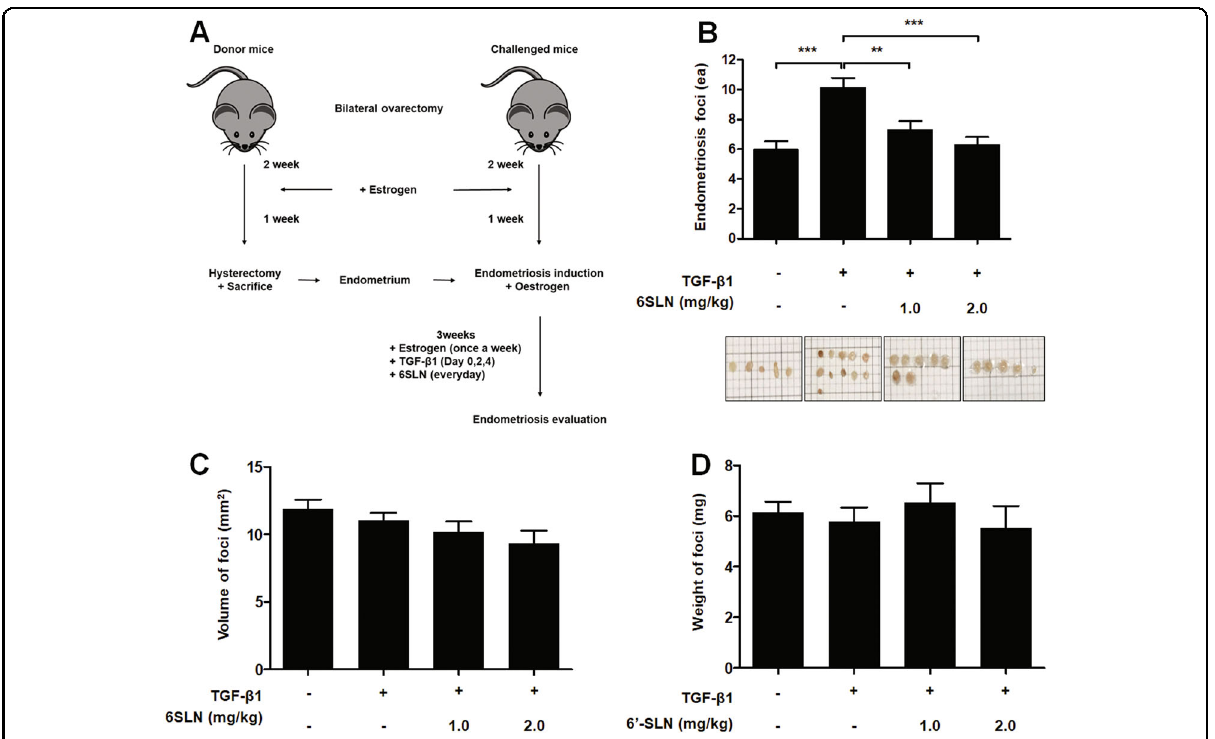
Fig. 6 6 ʹ -SLN treatment attenuates TGF- β 1-induced endometriosis in C57BL/6 mice a Schematic diagram of the mouse endometriosis model. Endometriosis was induced at day 0. Donor and challenged mice were subjected to ovariectomy at day − 21 and injected subcutaneously with estrogens (100 mg/kg) at days − 7, 0, + 7, + 14, and + 21. Mice challenged with endometrium were inoculated intraperitoneally with 2.5 μ g/kg TGF- β 1 (0, + 2, + 4 days) and 6 ʹ -SLN (daily). At day + 21 after endometriosis induction, challenged mice were killed, and endometriotic lesions were evaluated. b – d Endometriotic lesions were isolated, and the number, volume and weight of foci were calculated